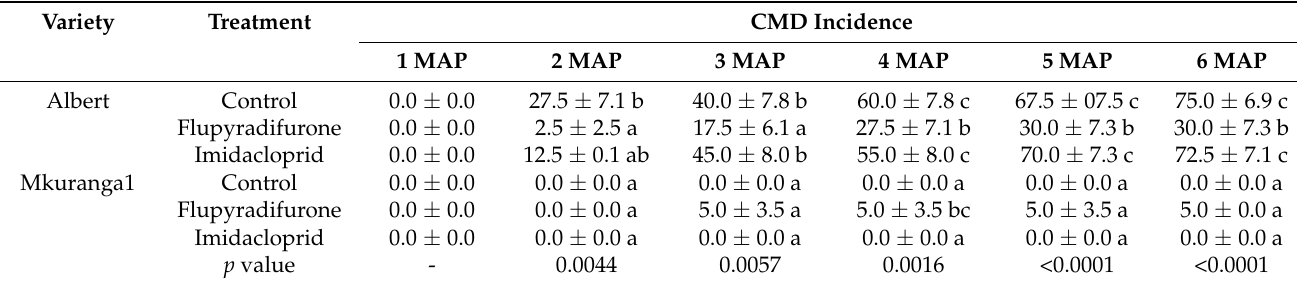
Table 7. Cassava mosaic disease (CMD) percentage incidence for cutting dipping method, 2020 (Means ± SE) Z .